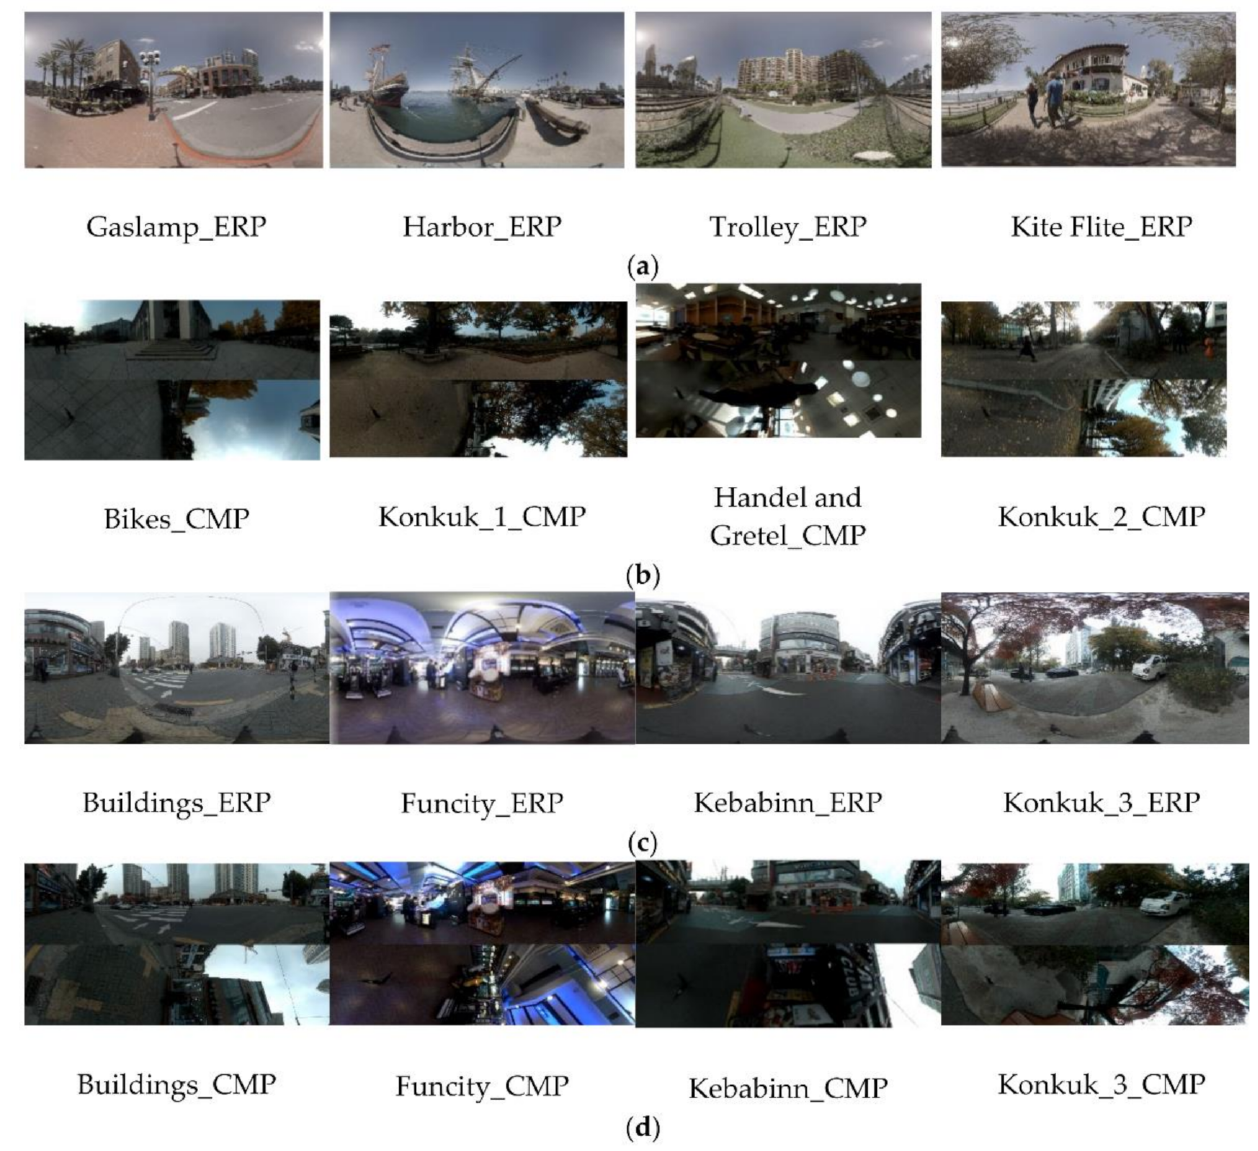
Figure 3. Selected test materials: ( a ) 8K ERP with size 8192 × 4096 [50], ( b ) 8K CMP with size 7680 × 3840, ( c ) 8K ERP with size 7920 × 5280, and ( d ) 8K CMP with size 7920 ×